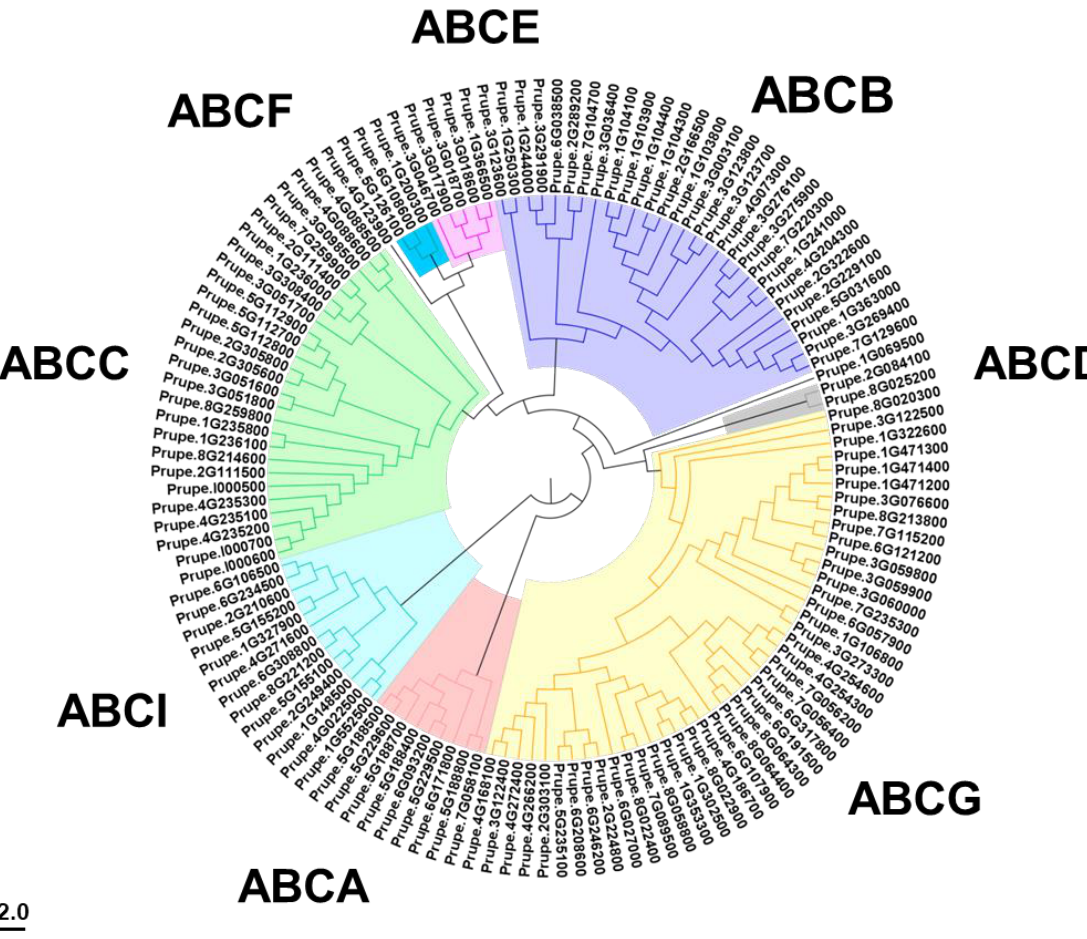
Figure 1. Phylogenetic analysis of ABC proteins from peach. The phylogenetic tree was constructed using the neighbor-joining method in MEGA 6.0 with 1000 bootstrap replicates. Different colors highlighted the eight subfamilies.